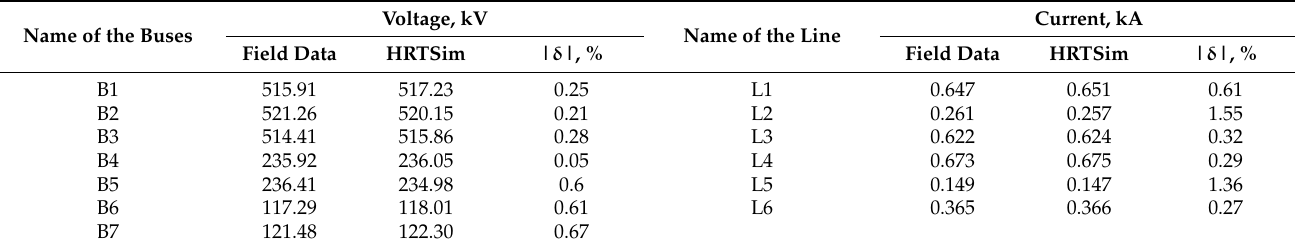
Table 2. Voltages in the Nodes of the EPS and Transmission Line Currents.